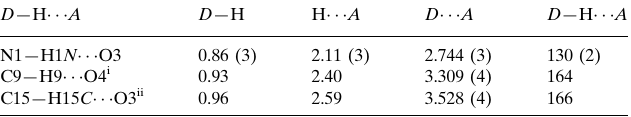
Hydrogen-bond geometry (A˚ , (cid:2)